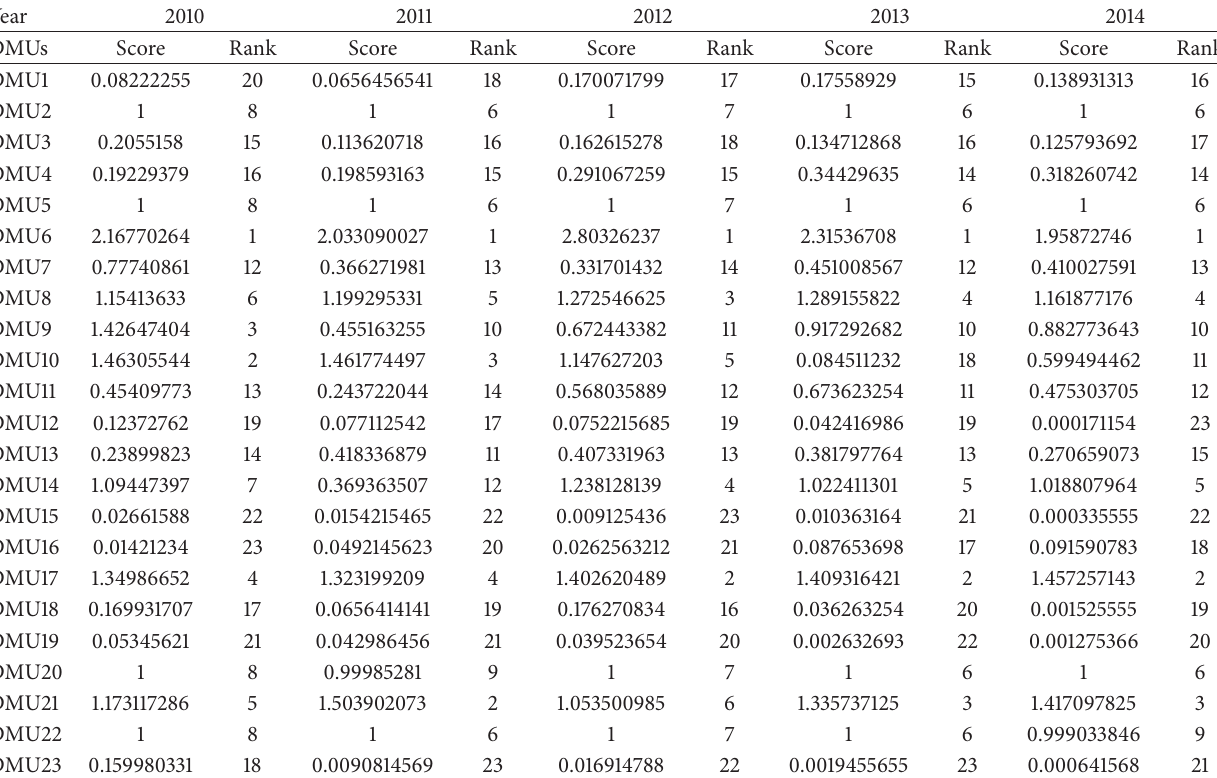
Table 8: Past-present period scores and rankings of Indian mining companies.